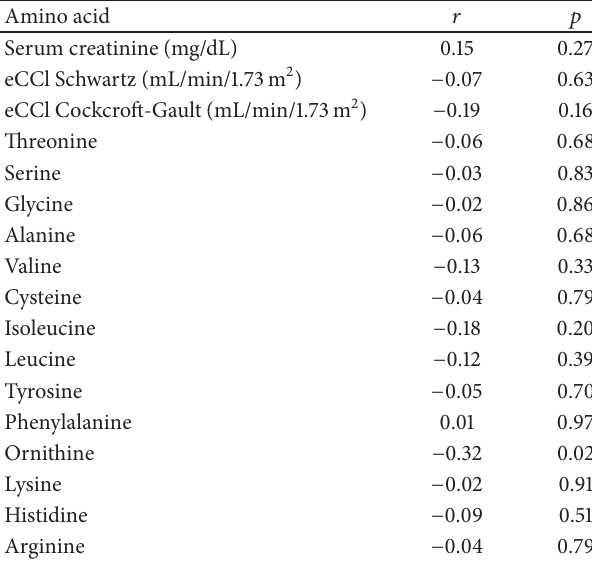
Table2:Correlationofrenalfunction,aminoacidtubularreabsorp- tion, and intravenous tobramycin courses in Tob+ group.